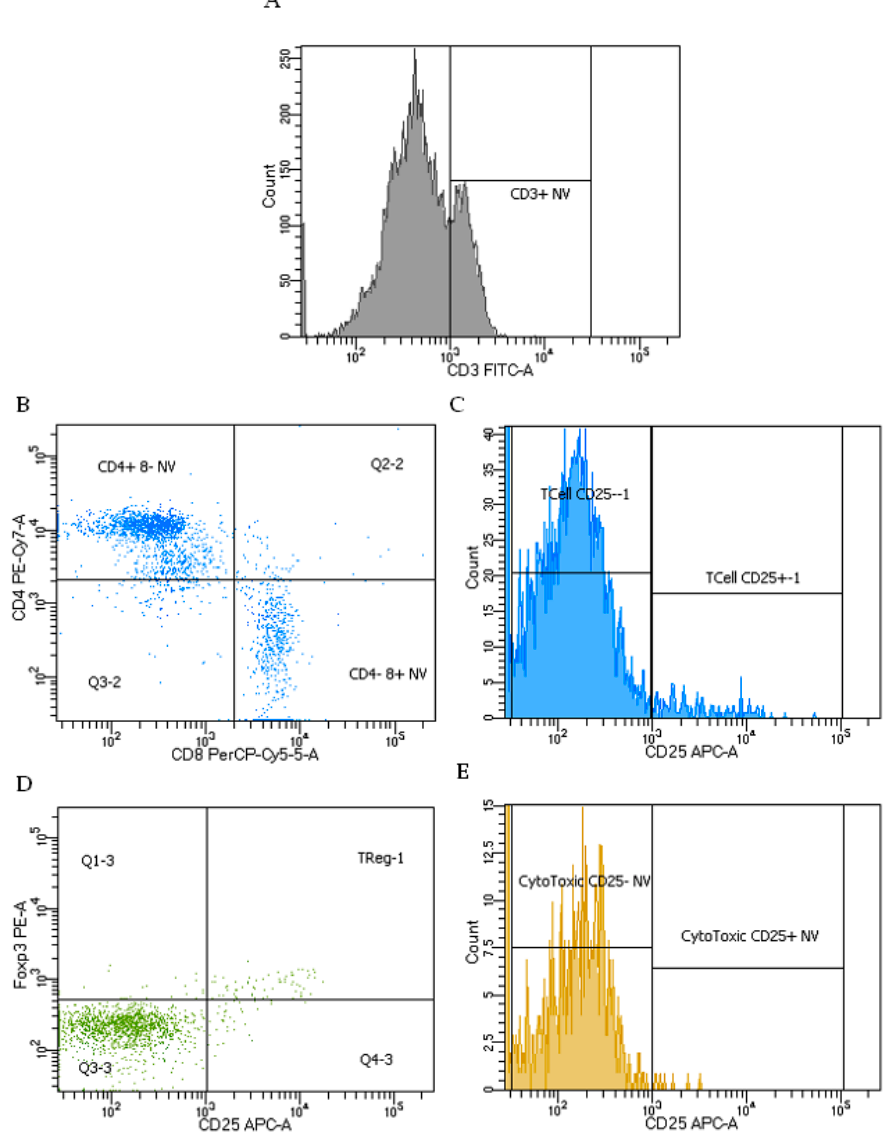
Figure 7. Representative flow cytometry plot for non-viable lymphocytes. ( A ) Definition of CD3